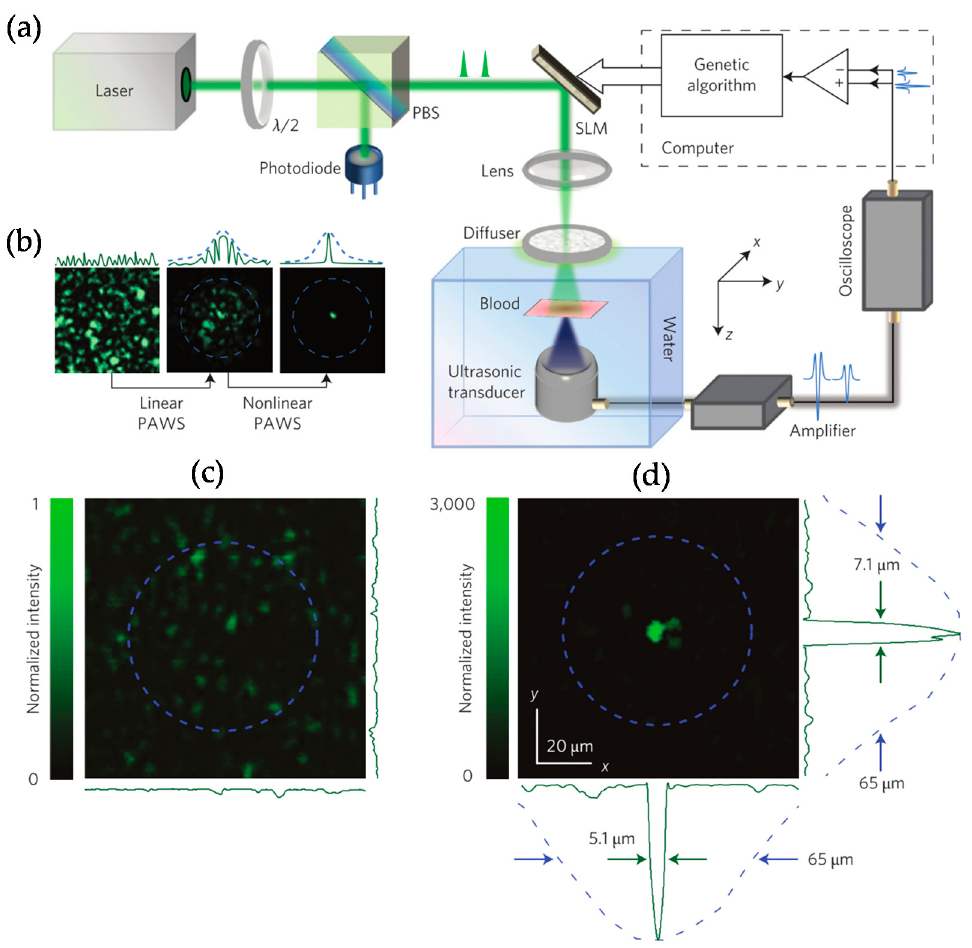
Figure 3. ( a ) Schematic of the two-stage PAWS experimental set-up. λ /2: half-wave plate; PBS: polarizing beam splitter; SLM: LCoS-type spatial light modulator; PAWS, photoacoustically-guided wavefront shaping. ( b ) a representative demonstration for optimization procedure with two stages: linear PAWS focuses light into the acoustic resolution (within the acoustic focal region denoted by blue dashed line); nonlinear PAWS focuses light down to optical resolution (observed as a single-speckle grain); ( c ) the observation upon speckle pattern behind the diffuser without phase modulation (a randomized phase pattern uploaded on the SLM); and ( d ) the optical focus down to optical resolution observed behind the diffuser with phase modulation by nonlinear PAWS (Figure from [48]).